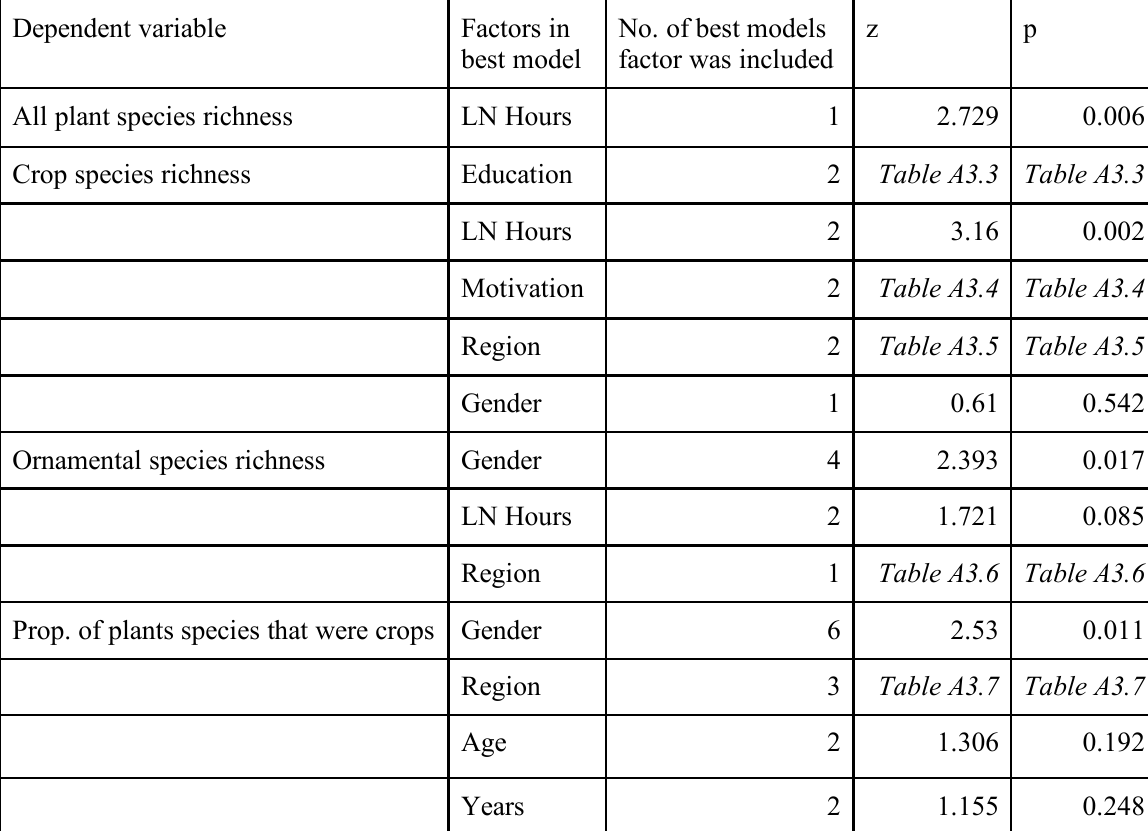
Table A3.2. GLMM model results for tests examining how gardener socio-demographic variables influence plant, crop and ornamental richness reported by gardeners as well as the proportion of plant species that were crops in urban gardens in the California central coast. All models results are for averaged models. Pairwise results for factors with multiple levels are reported in Tables A3.3-A3.7.